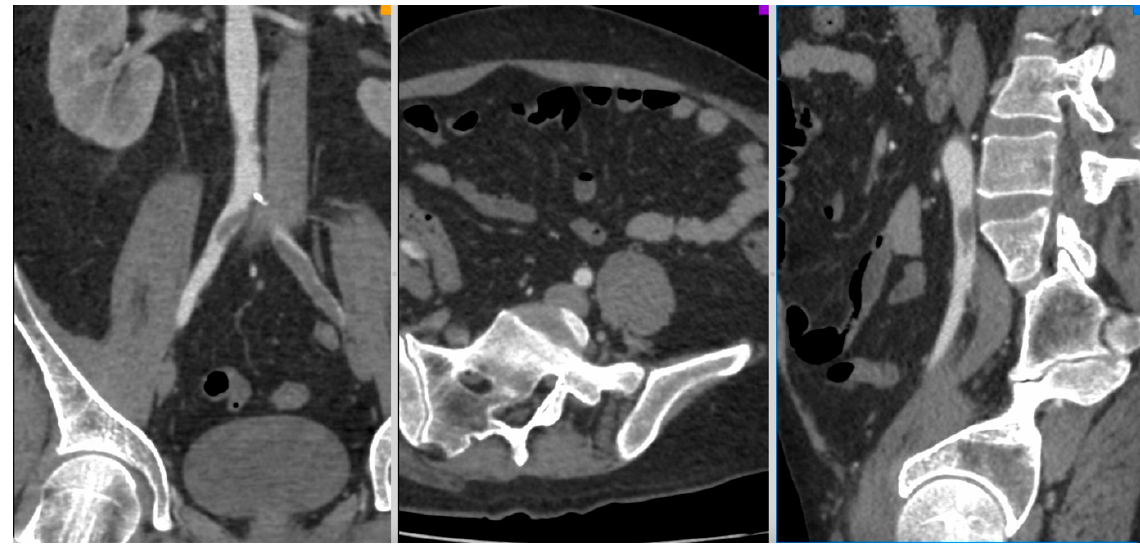
Figure 2. CT-Angio of a 42 yo male patient with aortic and iliac thrombosis with bilateral lower limb acute ischemia IIA Rutherford, 13 days after SARS-CoV-2 diagnosis.